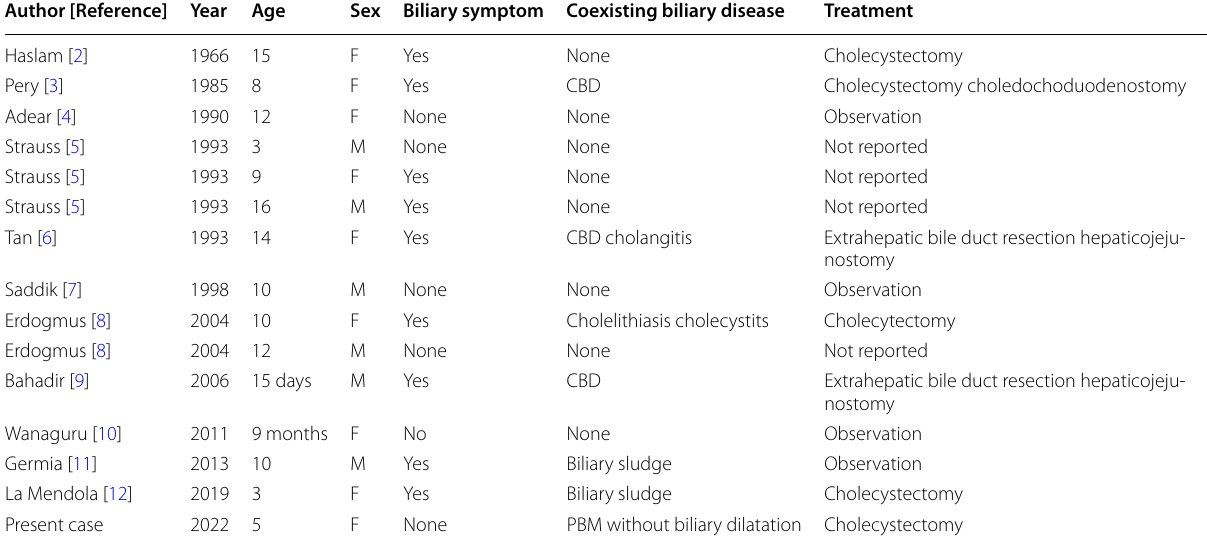
CBD congenital biliary dilatation, PBM pancreaticobiliary maljunction